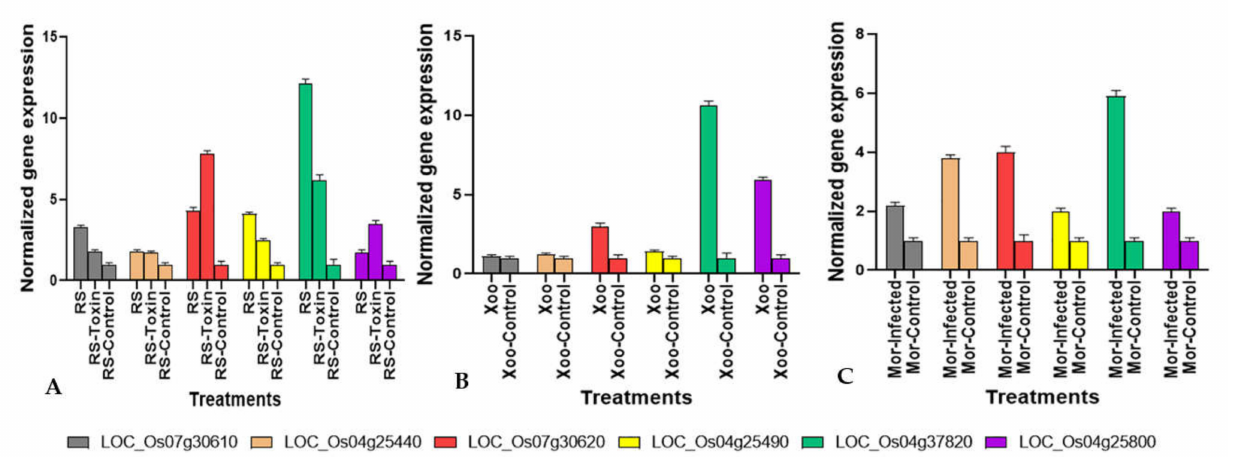
Figure 6. Quantification (qRT-PCR) of the expression of potential cytokinin-O-glucosyltransferase (CGT) genes of rice cultivars PBI infected with ( A ) Rhizoctonia solani (RS) and ( B ) Xanthomonas oryzae pv. oryzae (Xoo) and HP2216 infected ( C ) Magnaporthe oryzae (Mor) along with control inocula- tion at 48 h post-inoculation. The grey, brown, red, yellow, green, and purple bars represent the relative fold change of LOC_Os07g30610, LOC_Os04g25440, LOC_Os07g30620, LOC_Os04g25490, LOC_Os04g37820, and LOC_Os04g25800, respectively. Standard error bars show the standard devia- tions of three